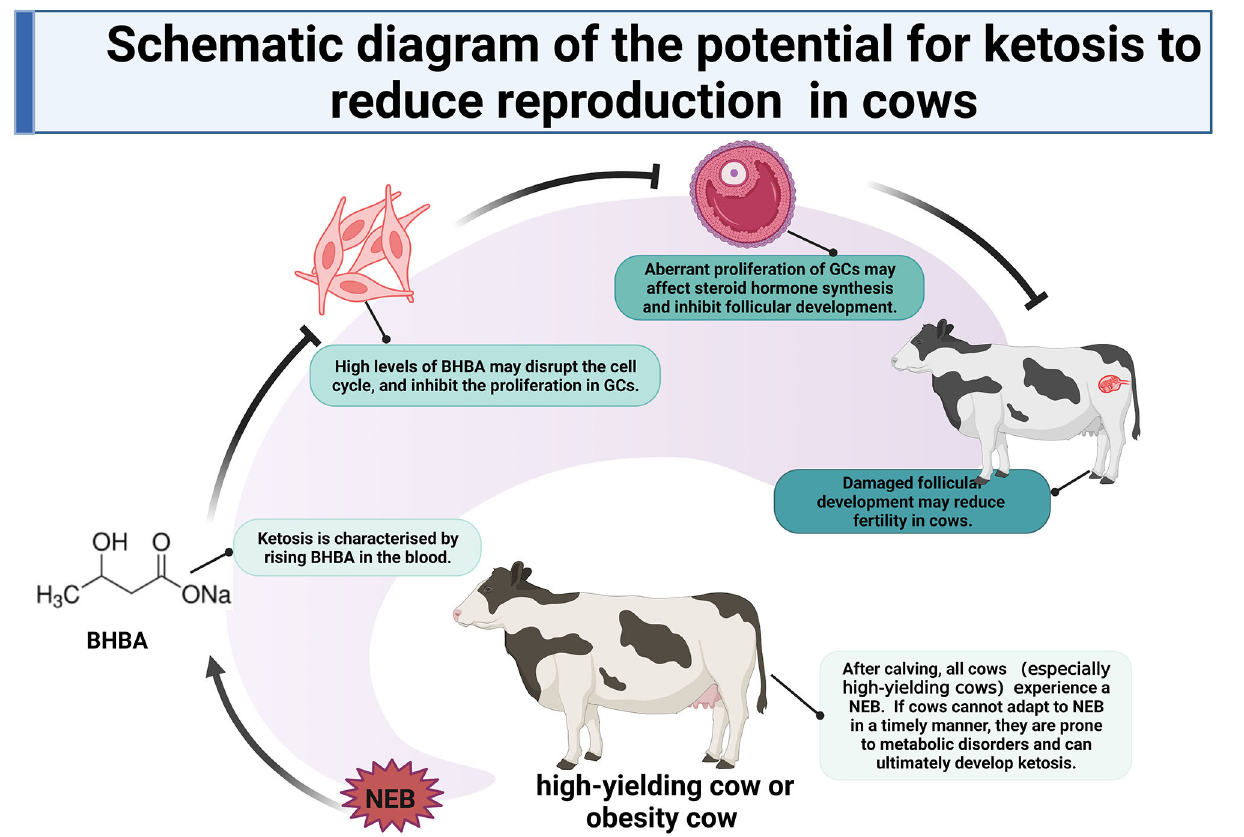
FIGURE 10 | Schematic diagram of the potential for ketosis to reduce reproduction in